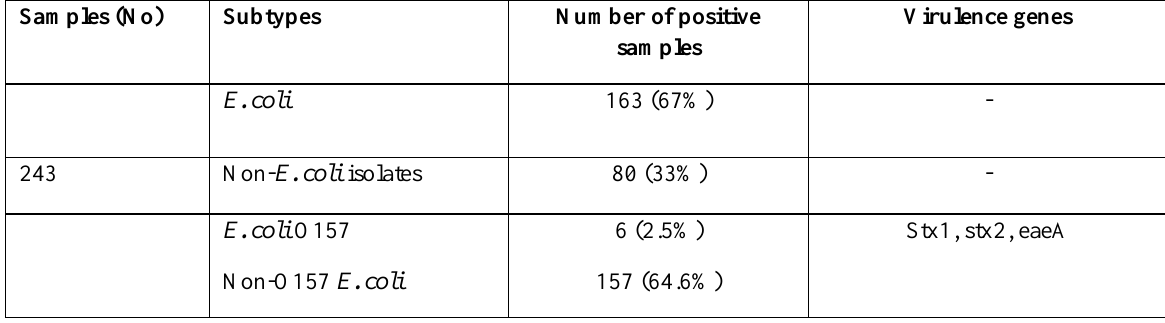
Table 3 . Prevalence of pathogenic subtypes and related virulence genes in STEC strains isolated from patients with diarrhea.